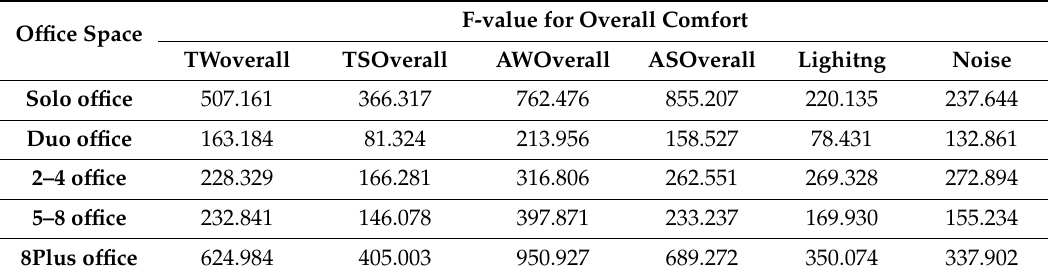
Table 5. The level of impact of IEQ variables on overall comfort and